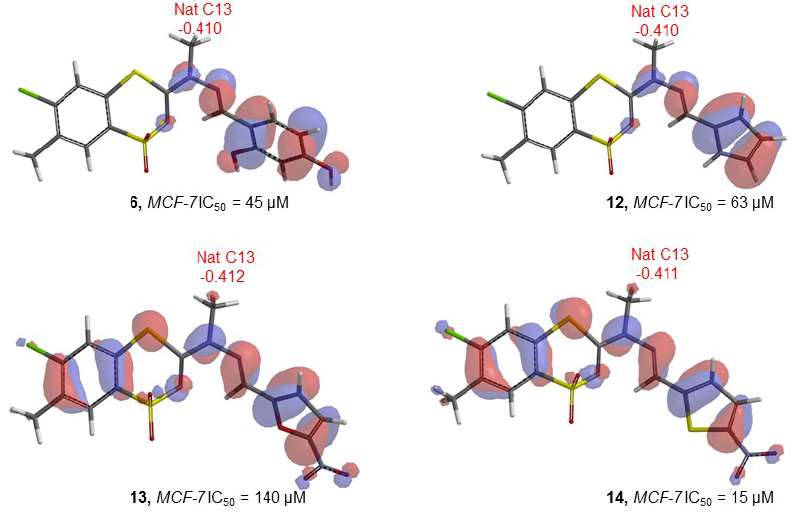
Figure 2. Isosurface plots of HOMO of compounds 6 , 12 , 13 and 14 , and natural charges on atom